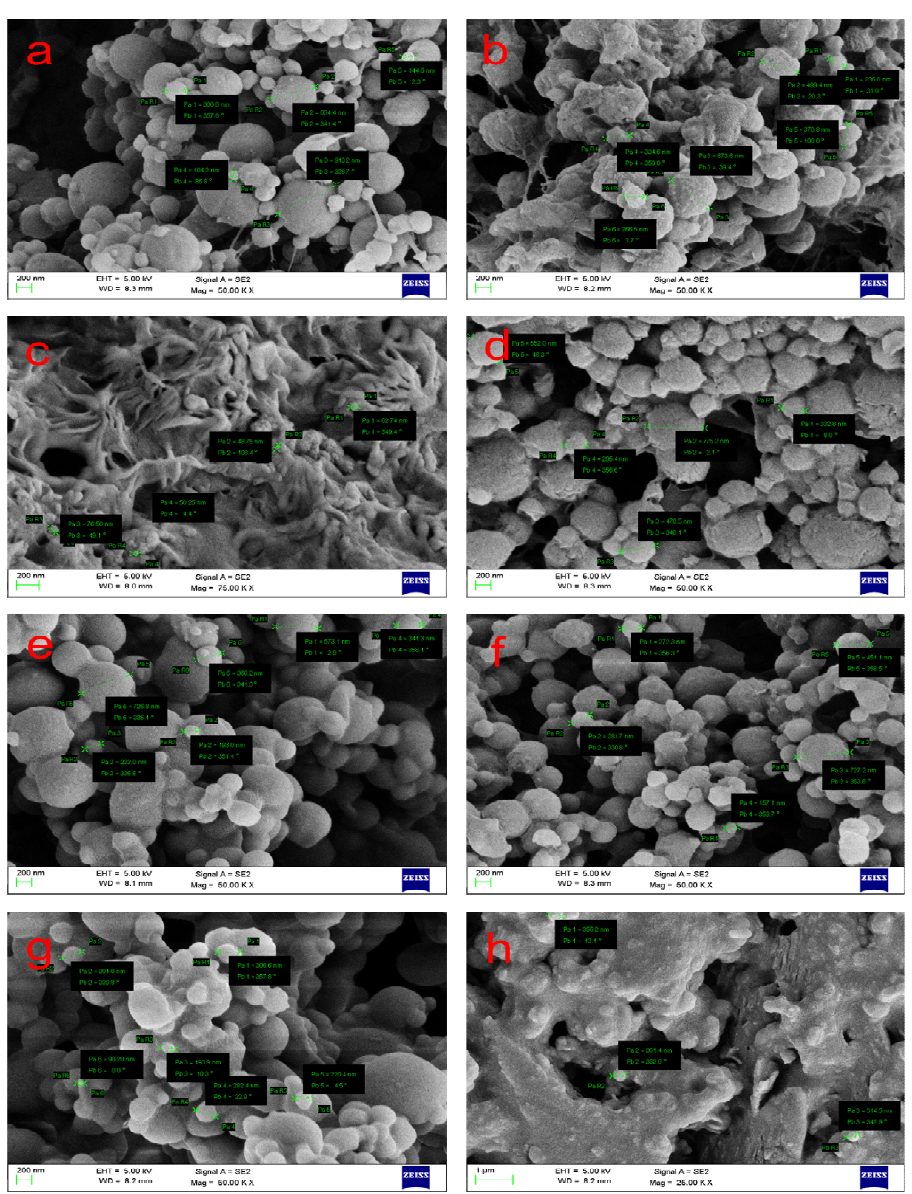
Fig.-2: SEM Analysis: Nanoparticles prepared using (a) Chloroform and DMSO, (b) Loaded, Chloroform and Figure 2. Scanning electron micrographs of synthesized P(3HB) NPs. ( a – d ) NPs were prepared using DMSO, (c) Chloroform and Water, (d) Loaded, Chloroform and water, (e) Ethyl acetate and DMSO,(f) Loaded, chloroform and ( a ) DMSO, ( b ) DMSO (loaded), ( c ) water ( d ) water (loaded), ( e – h ) ethyl acetate, Ethyl acetate and DMSO, (g) Ethyl acetate and Water, (h) Loaded, Ethyl acetate and Water and ( e ) DMSO, ( f ) DMSO (loaded) ( g ) water, ( h ) water (loaded). Adapted from Senthilkumar et al. (2018)